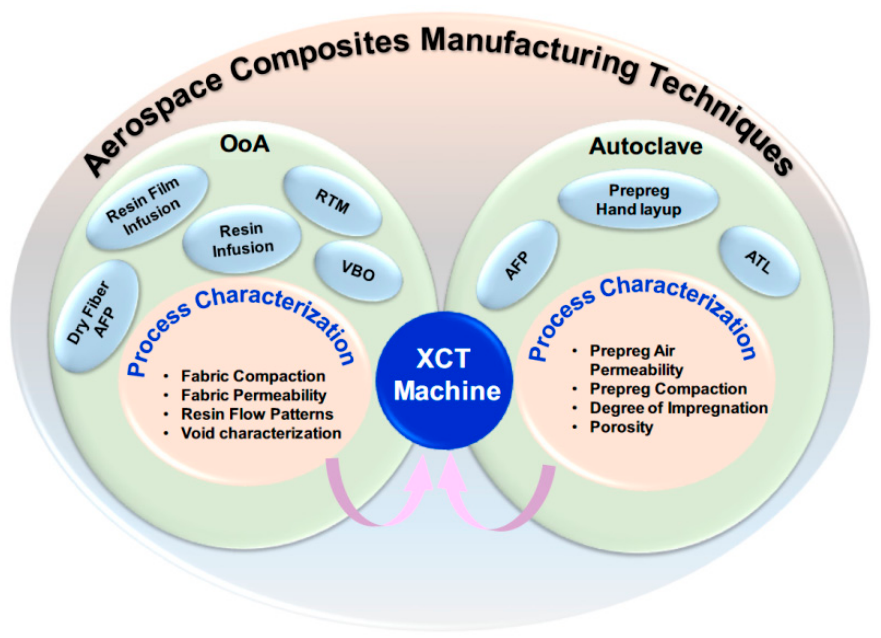
Figure 9. Potential application of XCT in aerospace composite manufacturing techniques (reproduced with permission from [229]; copyright© 2021 The Authors. Published by Elsevier Ltd.).